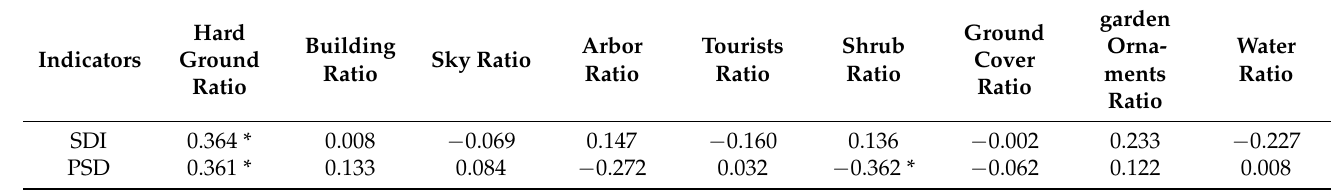
Table 2. Correlation between the PSD, the SDI and the proportion of landscape spatial elements.